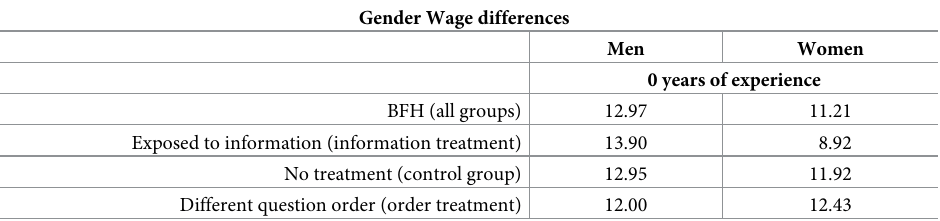
Table 2. Deviations from Reality: Percentage differences between expected and realized